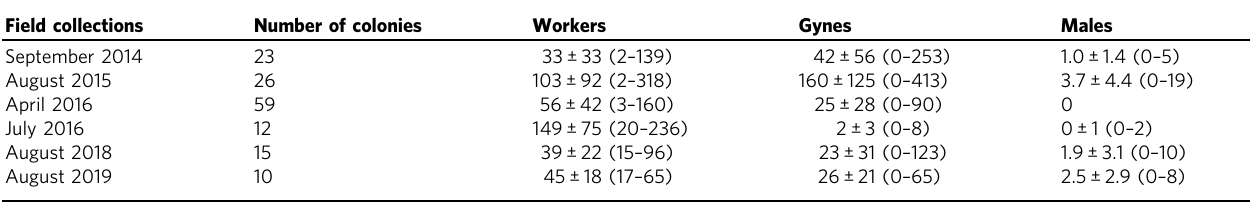
Table 2 Composition of colonies of the ant Cardiocondyla elegans .